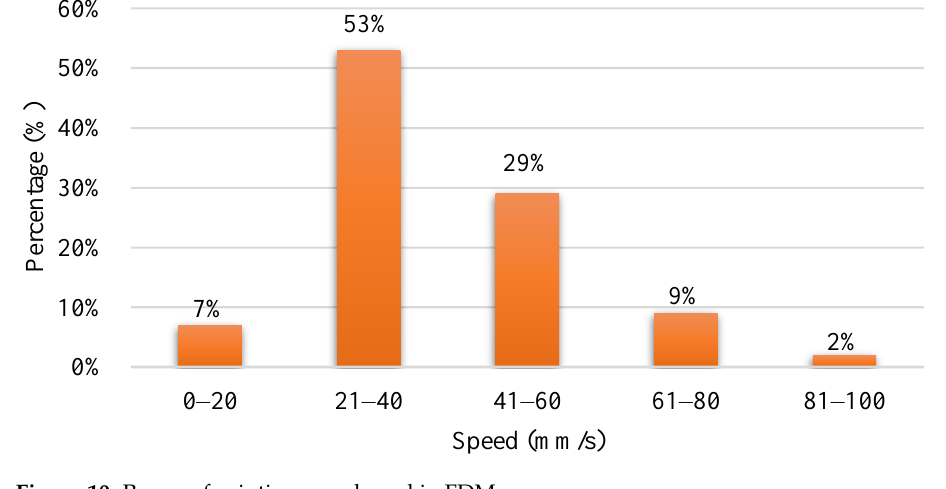
Figure 10. Range of printing speed used in FDM process.